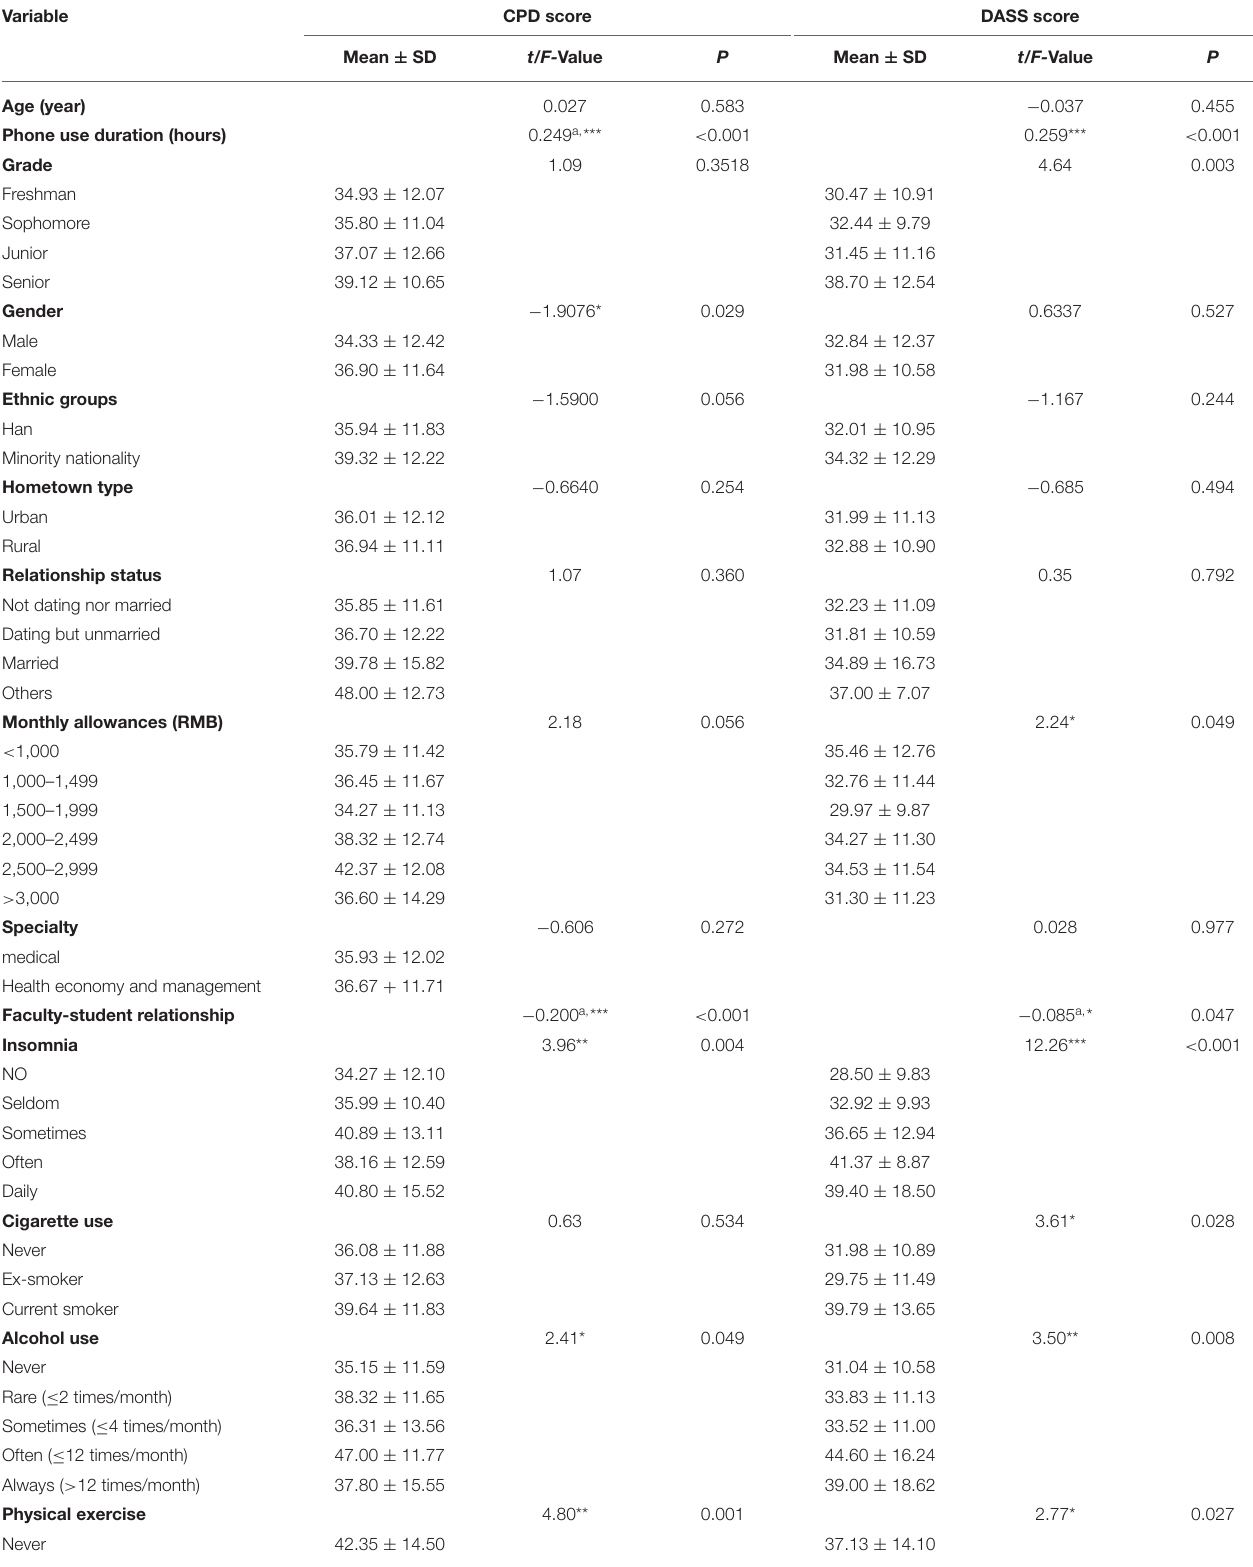
TABLE 2 | Univariate/correlation analysis results ( N =